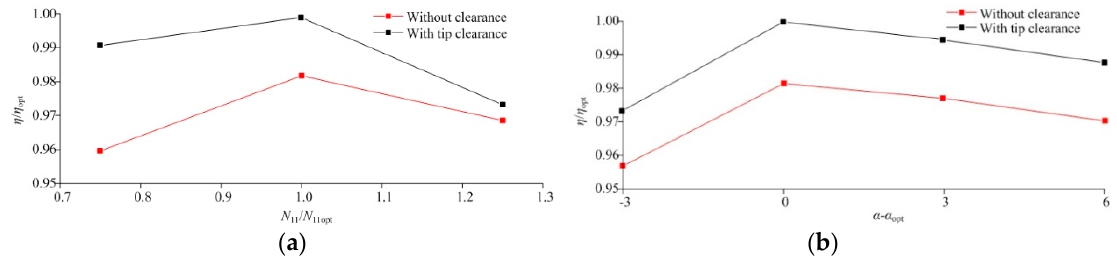
Figure 24. Comparison of efficiency of ( a ) N 11 (unit speed) versus ( b ) α (guide-vane angle) for turbines without clearance and with tip clearance [53].